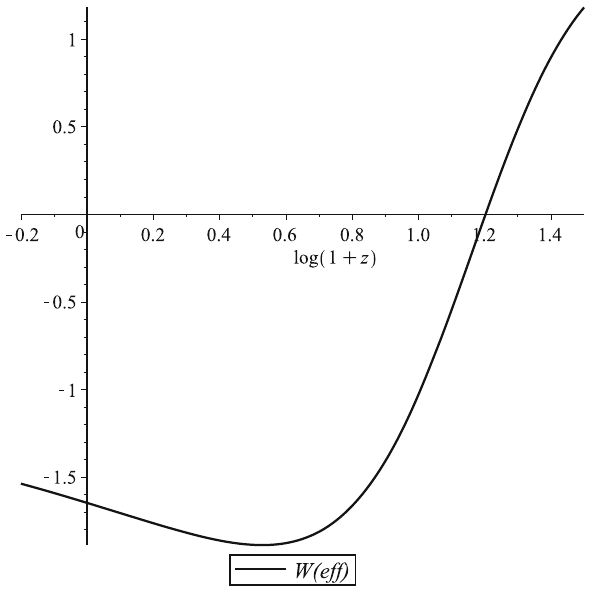
Fig. 3 Effective EoS w eff for b = 0 . 5 , b = 0 . 7 , b = 0 . 9. The three curves coincides. Here, the horizontal axis shows log ( 1 + z ) and the vertical axis shows the value of w eff